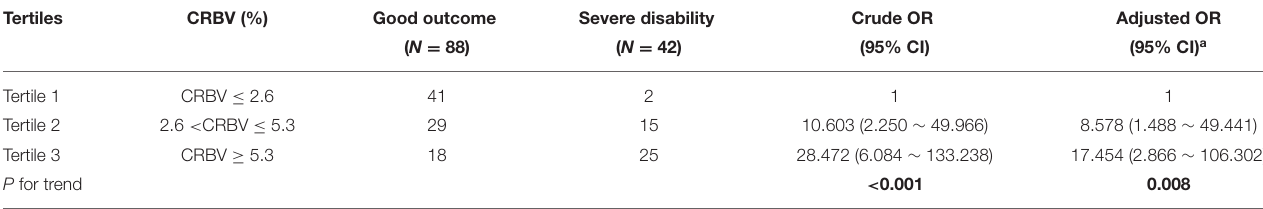
TABLE 5 | Outcome association with stratified analysis of the CRBV. Tertiles